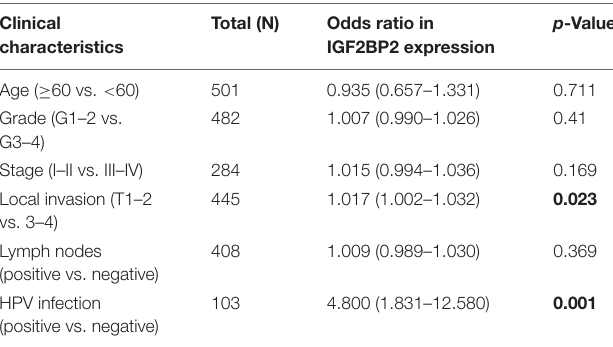
TABLE 2 | Correlation between the clinicopathologic characteristics and IGF2BP2 mRNA expression a (logistic regression). Clinical